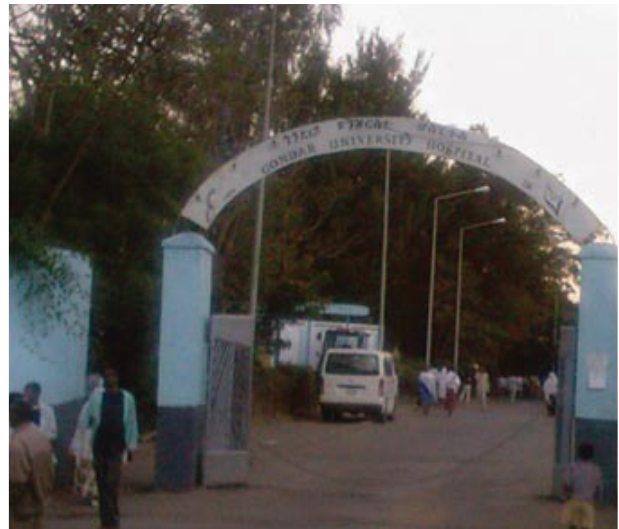
Figure 3 The main entrance to the Gondar University Hospital